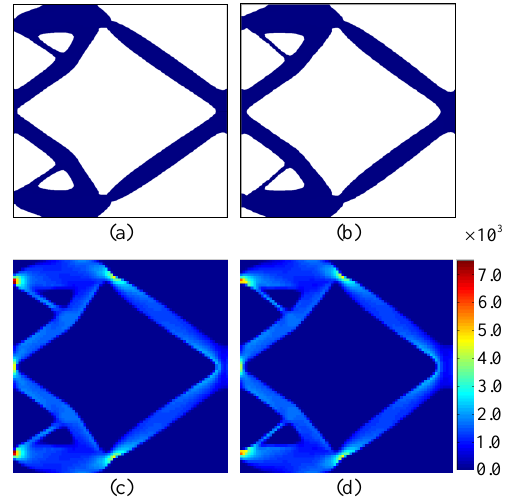
Figure 5. Optimal configurations: (a) without stress constraint; (c) Von Mises stress distribution of (a) ; (b) with stress constraint; (d) Von Mises stress distribution of (b) .